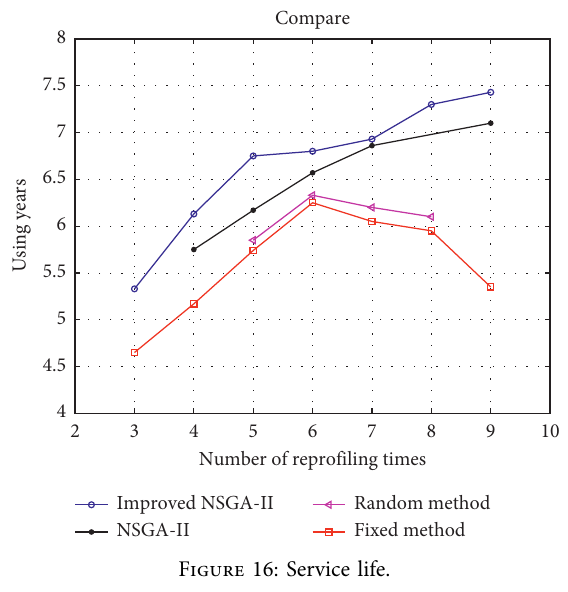
Figure 16: Service